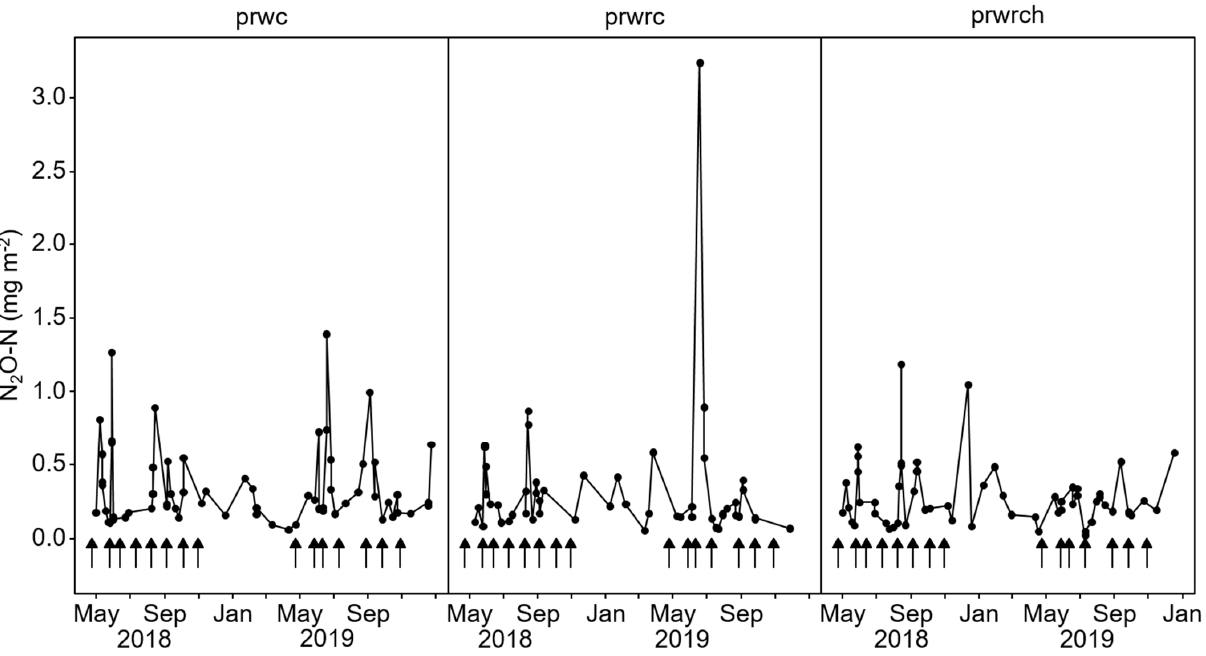
Figure 2. Daily N 2 O-N emissions from diverse grasslands grazed by dairy cows. prwc : Perennial ryegrass and white clover swards; prwrc : Perennial ryegrass, white- and red clover swards; prwrch : Perennial ryegrass, white- and red clover + herbs. The arrows indicate grazing events.